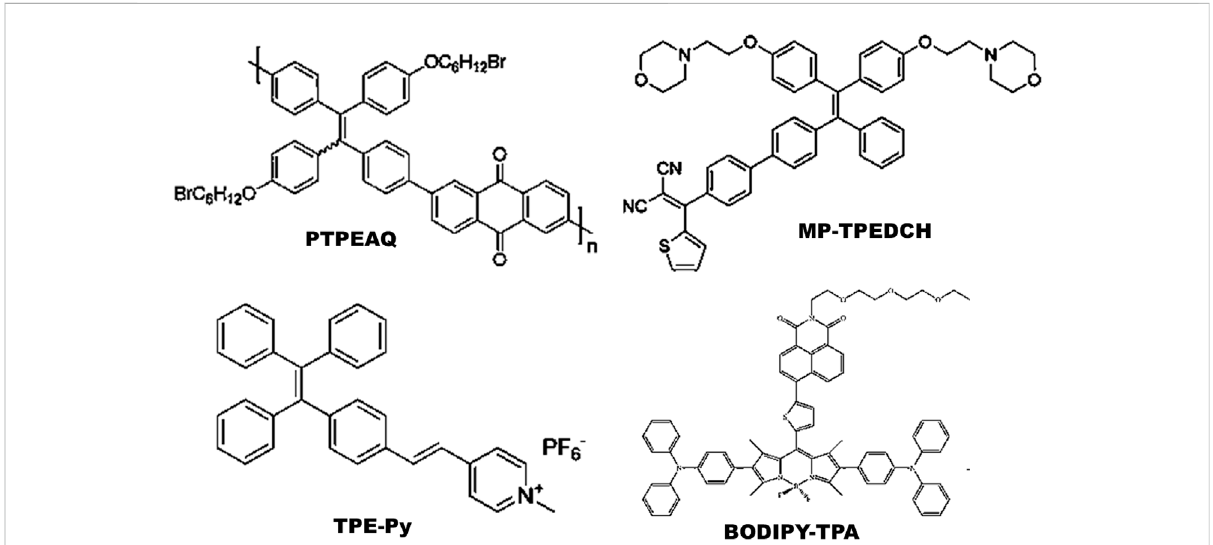
FIGURE 4 Illustrations for AIE(donor)-Acceptor photosensitizers: These are constructed on tetraphenylethene (TPE) cytoskeleton with a D-A or D- π -A structure. Addition of spacer ( π ) between donor (D) and acceptor (A) may decrease the singlet energy gap ( Δ E ST ). Source: PTPEAQ (Wu et al., 2016), MP-TPEDCH (Huang et al., 2021), TPE-Py (Zhuang et al., 2019), BODIPY-TPA (Deng et al., 2021). Please refer Tables 2 – 5 for